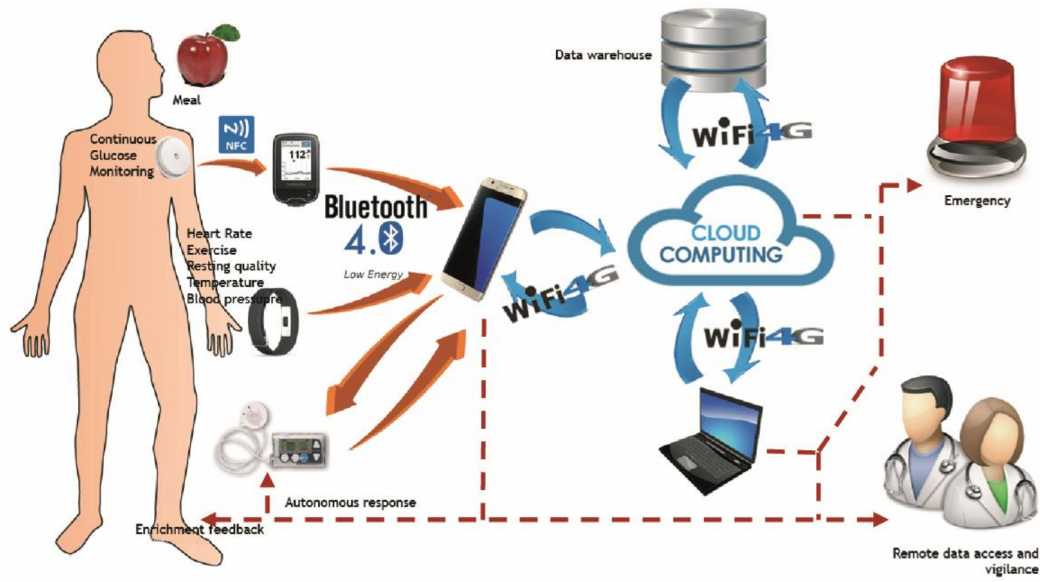
Figure 2. Diagram of the flows of